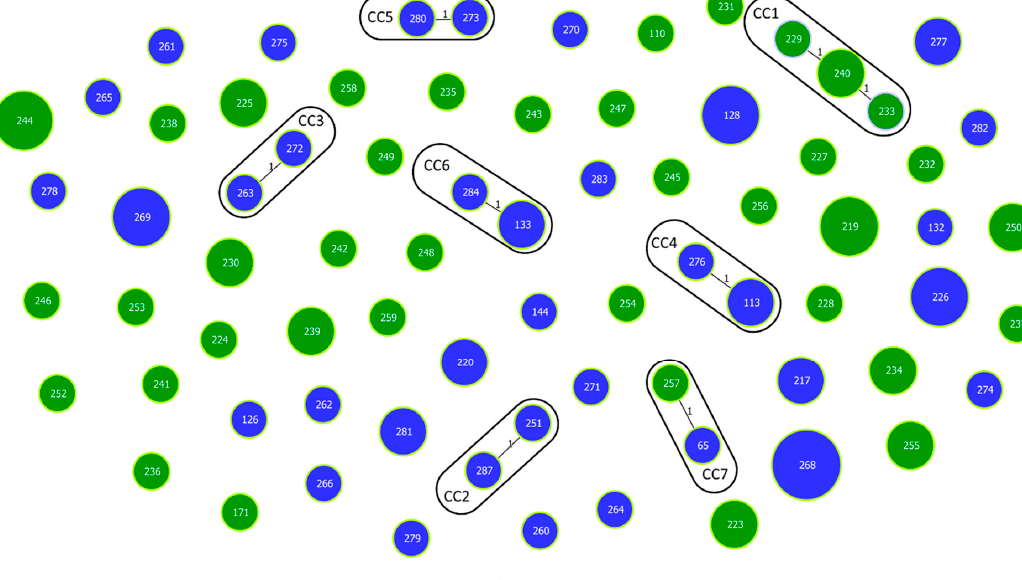
Figure 2. Cont. Figure 2.